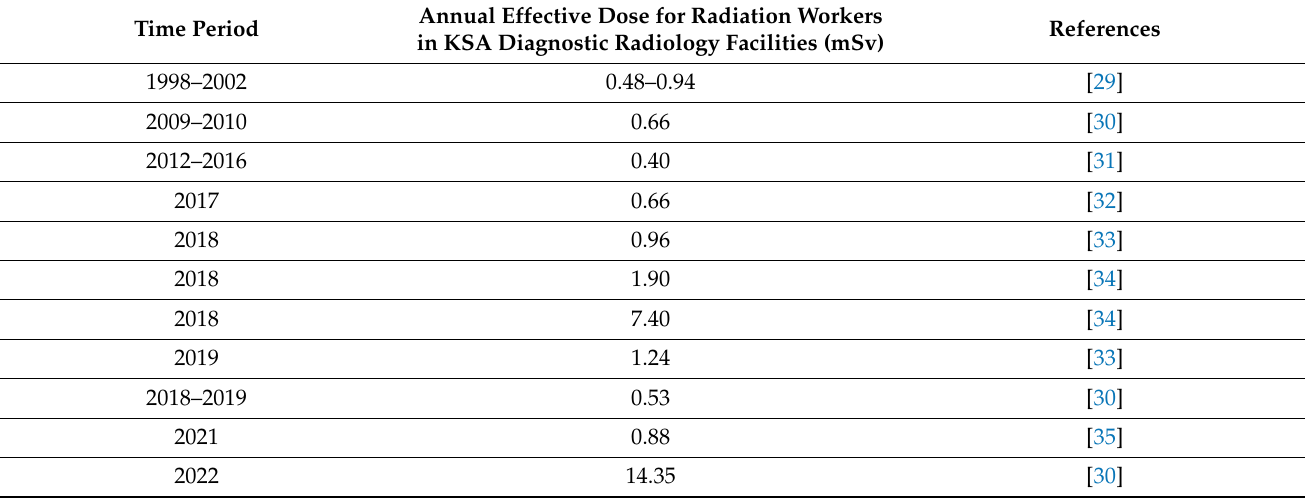
Table 3. Annual effective dose in diagnostic radiology facilities in Saudi Arabia during the period from 1998 to 2022. Annual Effective Dose for Radiation Workers Time Period in KSA Diagnostic Radiology Facilities